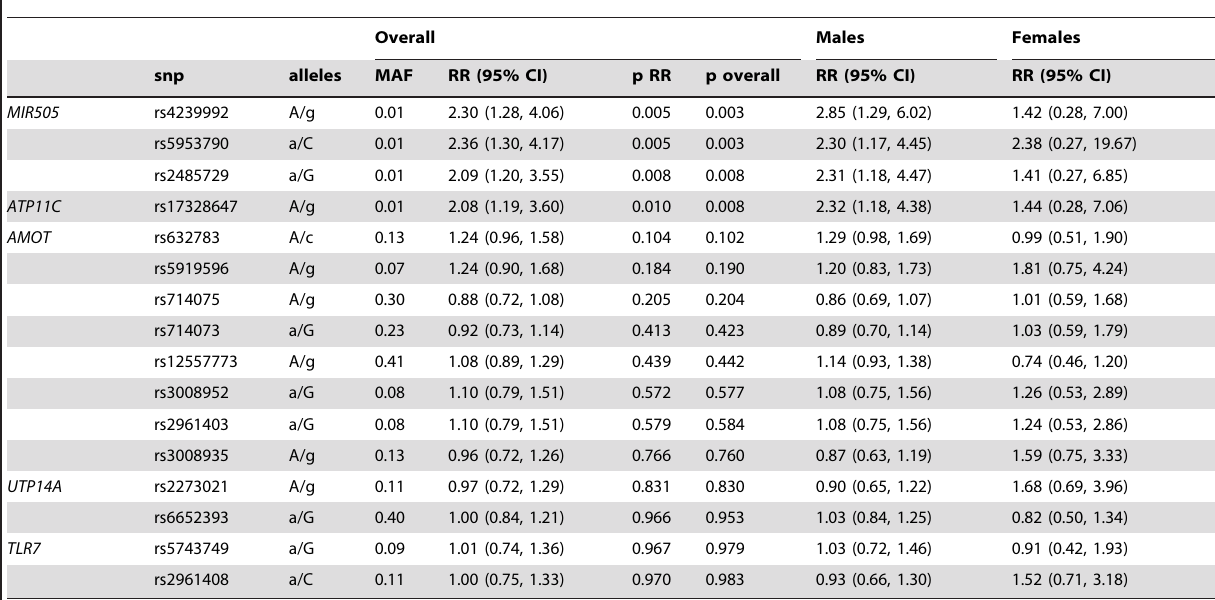
Table 9. Replication of fetal SNPs in the US study.